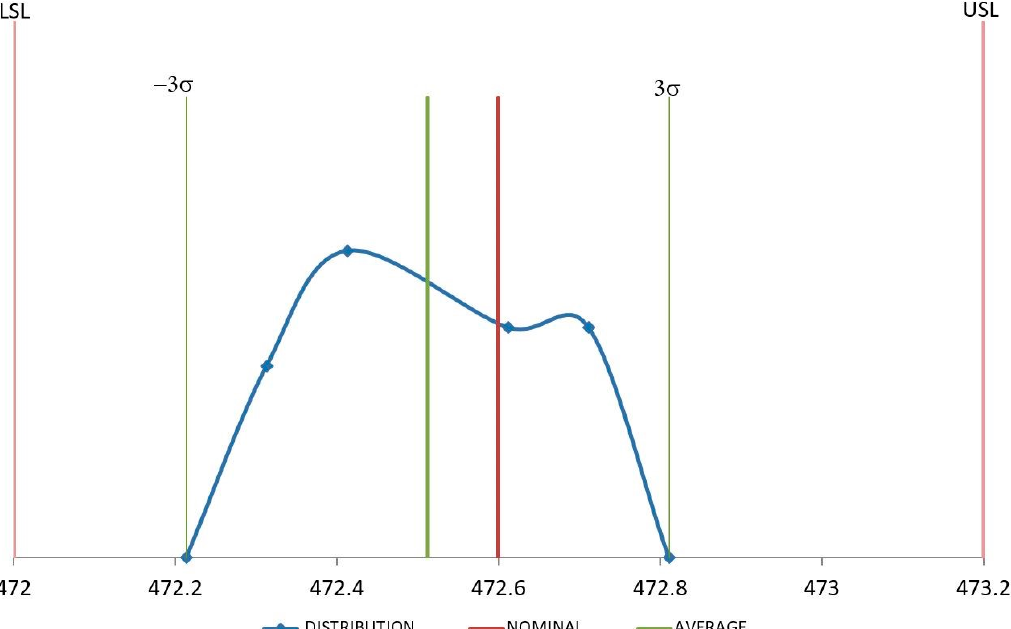
Figure 11. Distribution for D4 (mm) with recycled material.